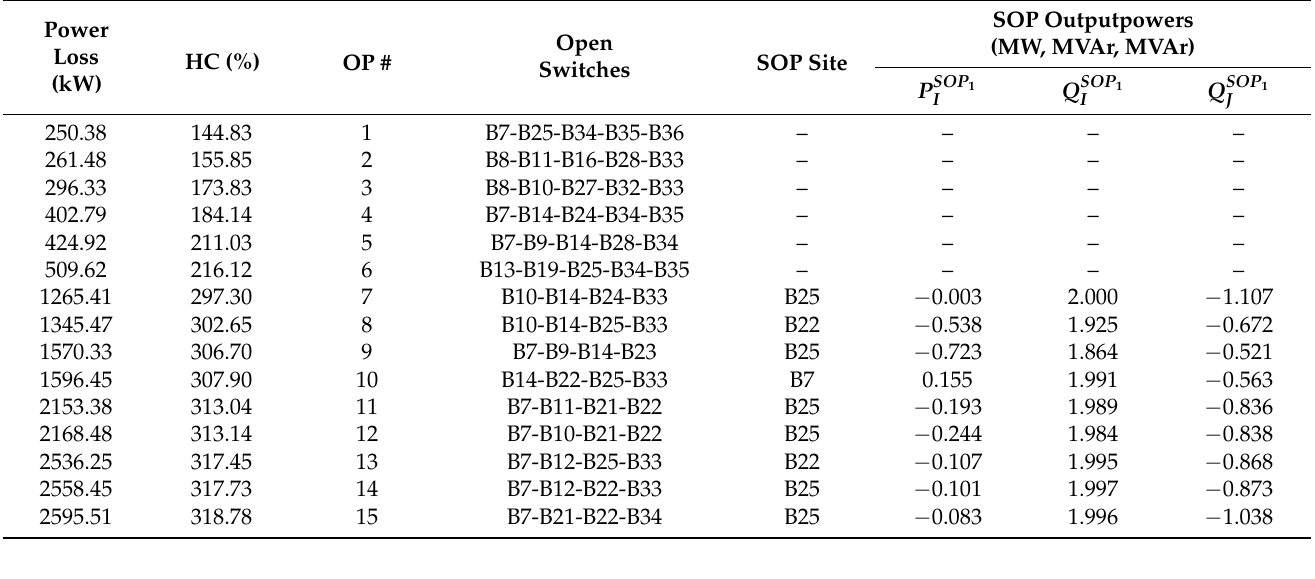
Table 6. Nondominated solutions from MOAIS, Case 2.